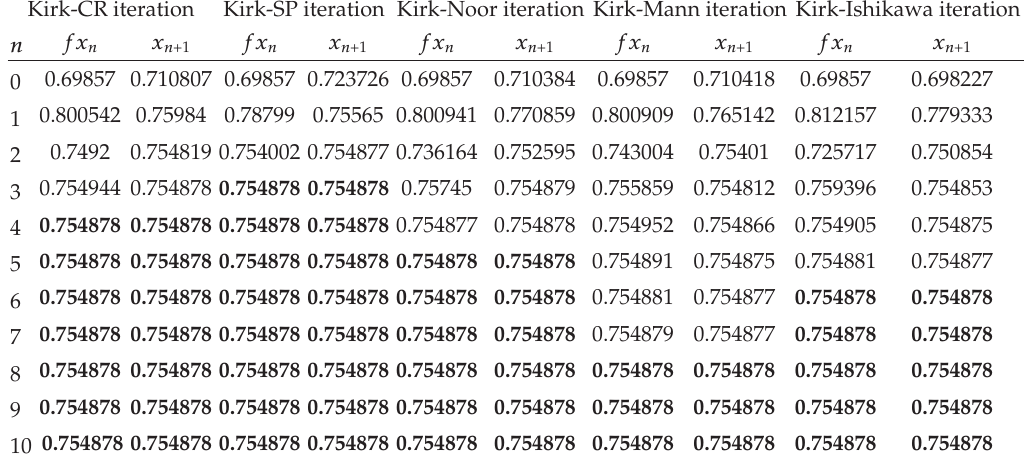
Table 1: Decreasing cum sublinear functions.